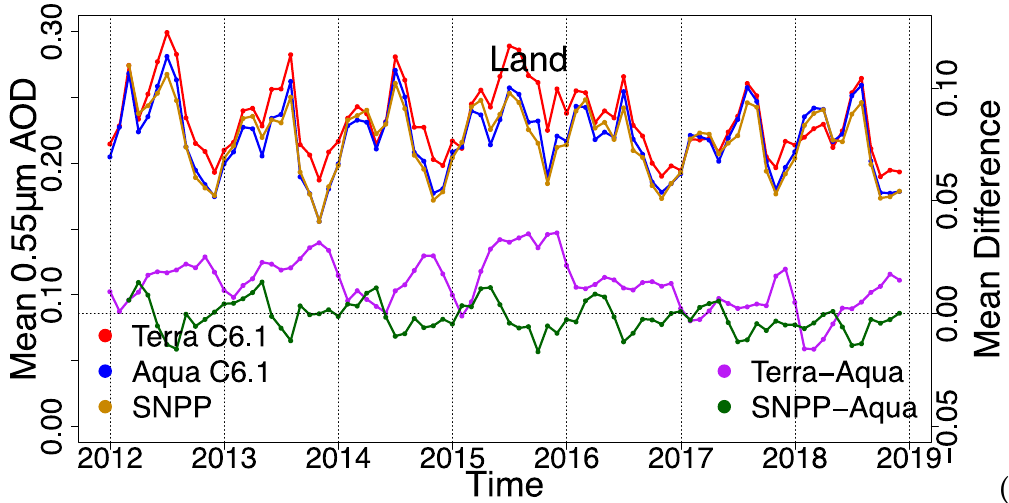
Figure 3. Area-weighted monthly global average 0.55 µ m AOD for MODIS Terra, MODIS Aqua, and VIIRS SNPP, ( a ) over ocean and ( b ) over land, with absolute AOD averages on the left axis and differences between sensors on the right axis.